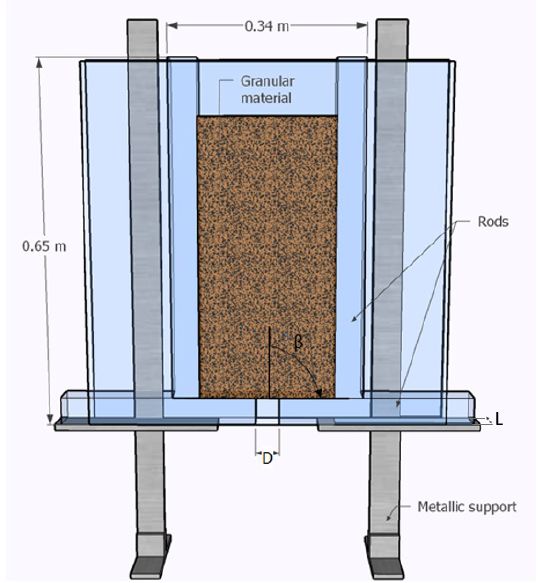
Table 1. Values for di ff erent parameters of the seeds used